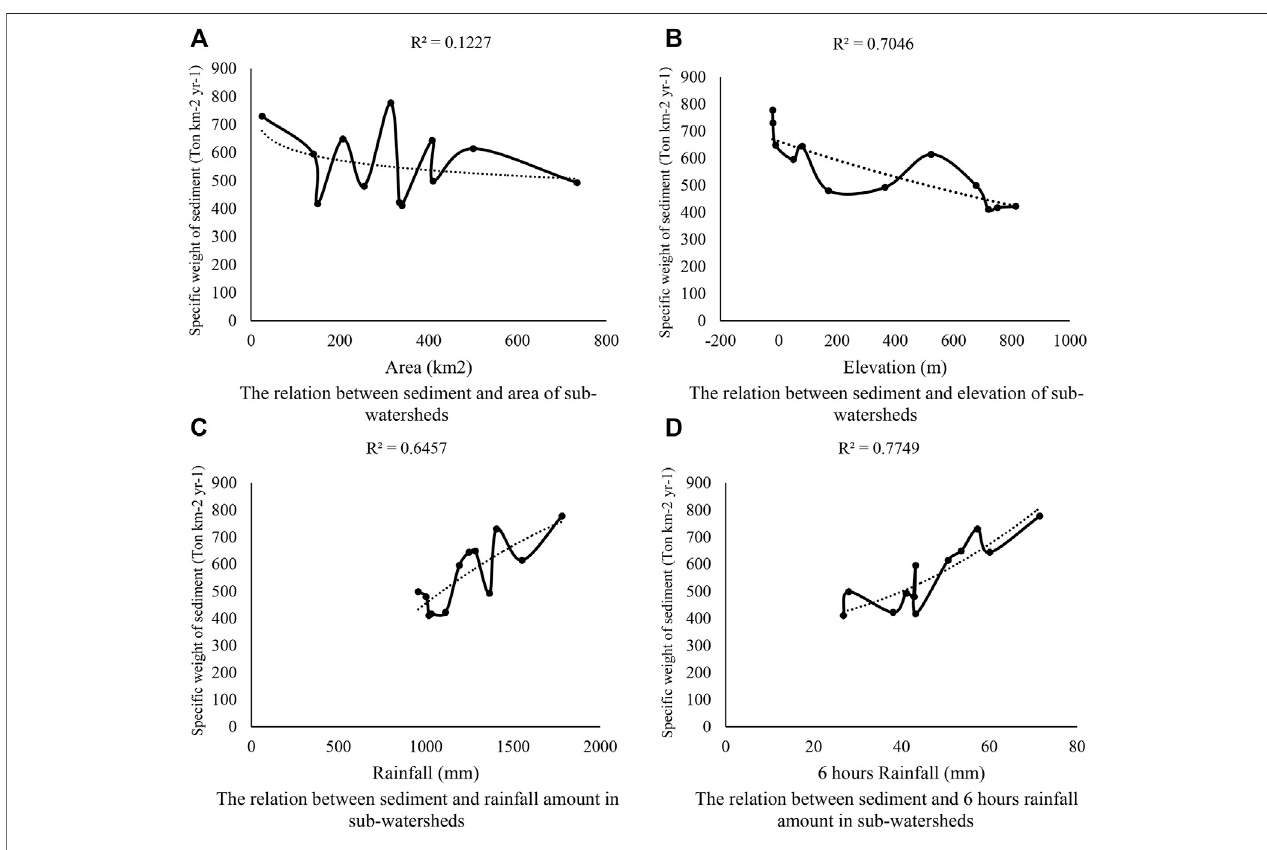
FIGURE 4 | The relation between sedimentation and climatology of the sub-watershed.